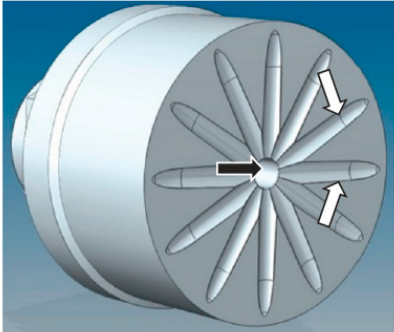
Figure 1. A scheme of the periodically rotated die with marked die opening (black arrow) and grooves (white arrows) applied to Mg-Csf composite bar cold working by KoBo-extrusion.